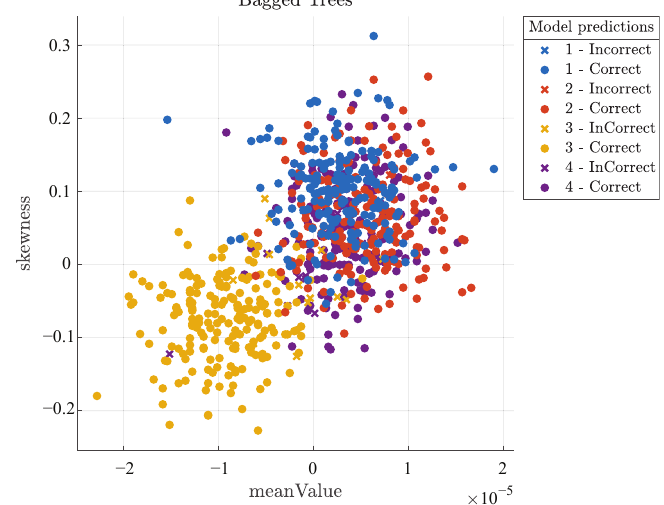
Figure 18. Scatter diagram of bagging.